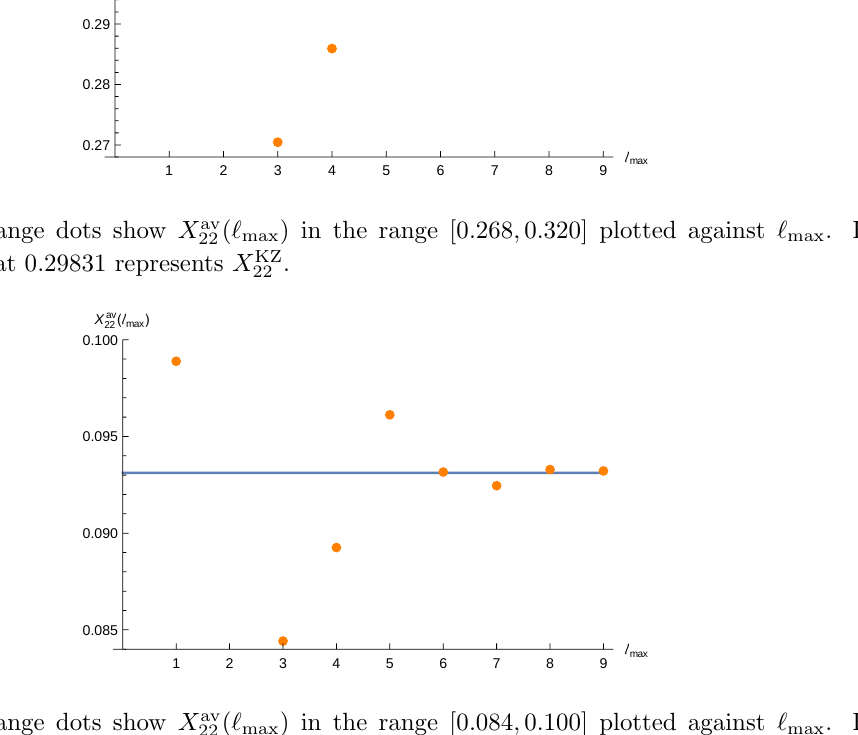
Figure 2 . Orange dots show X av horizontal line at 0 : 0931172 represents X KZ